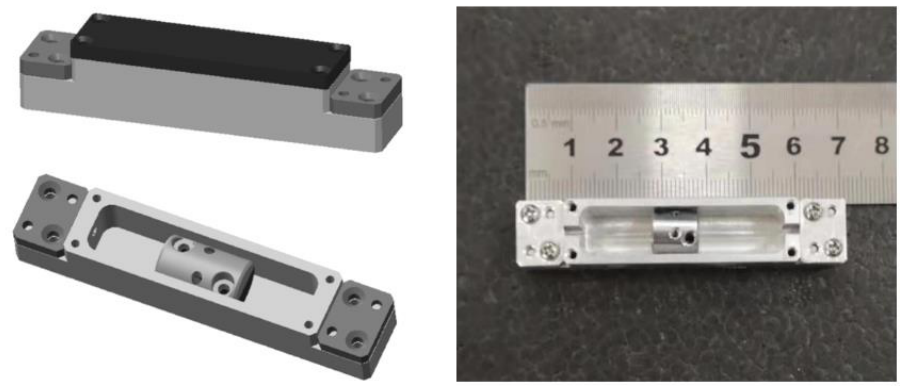
Figure 1. The structure diagram of the accelerometer.